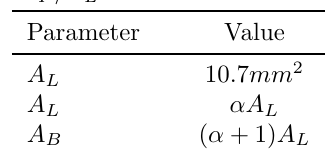
Table 3: Measured effective cross-sectional spool areas, α = A P /A L = 2 . 72.